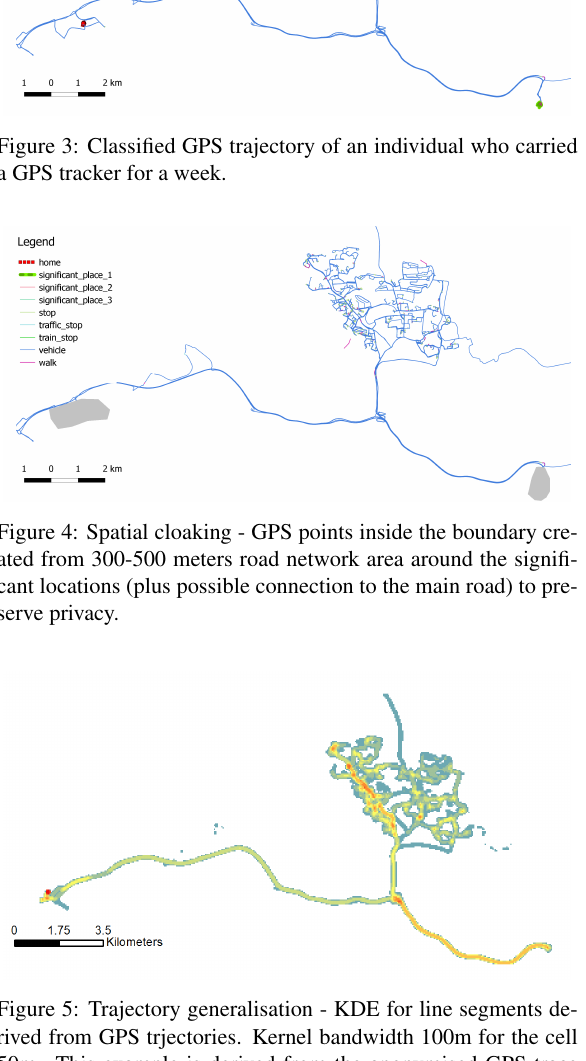
Figure 7: Trajectory generalisation - KDE for line segments de- rived from GPS trajectories. Kernel bandwidth 300m and the cell 100m. Similarly to the Figure above, this generalisation is pre- pared from the raw dataset for one individual user, therefore sig- nificant locations which were not eliminated can be